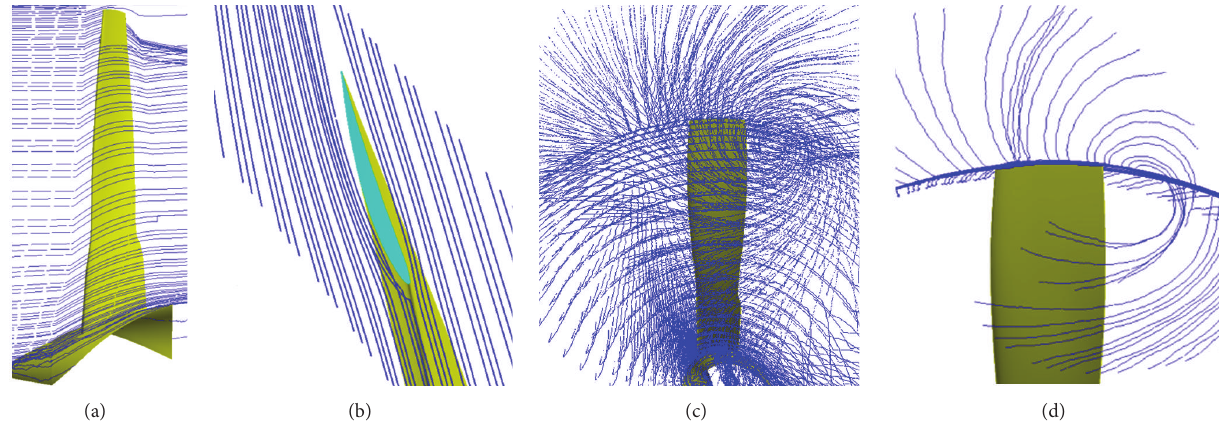
Figure 7: Sample of sand particle (10 𝜇 m) trajectories: (a) streamwise from hub to shroud, (b) near the tip, (c) downstream of rotor blade, and (d) downstream of rotor blade reflecting particles crossing over the blade